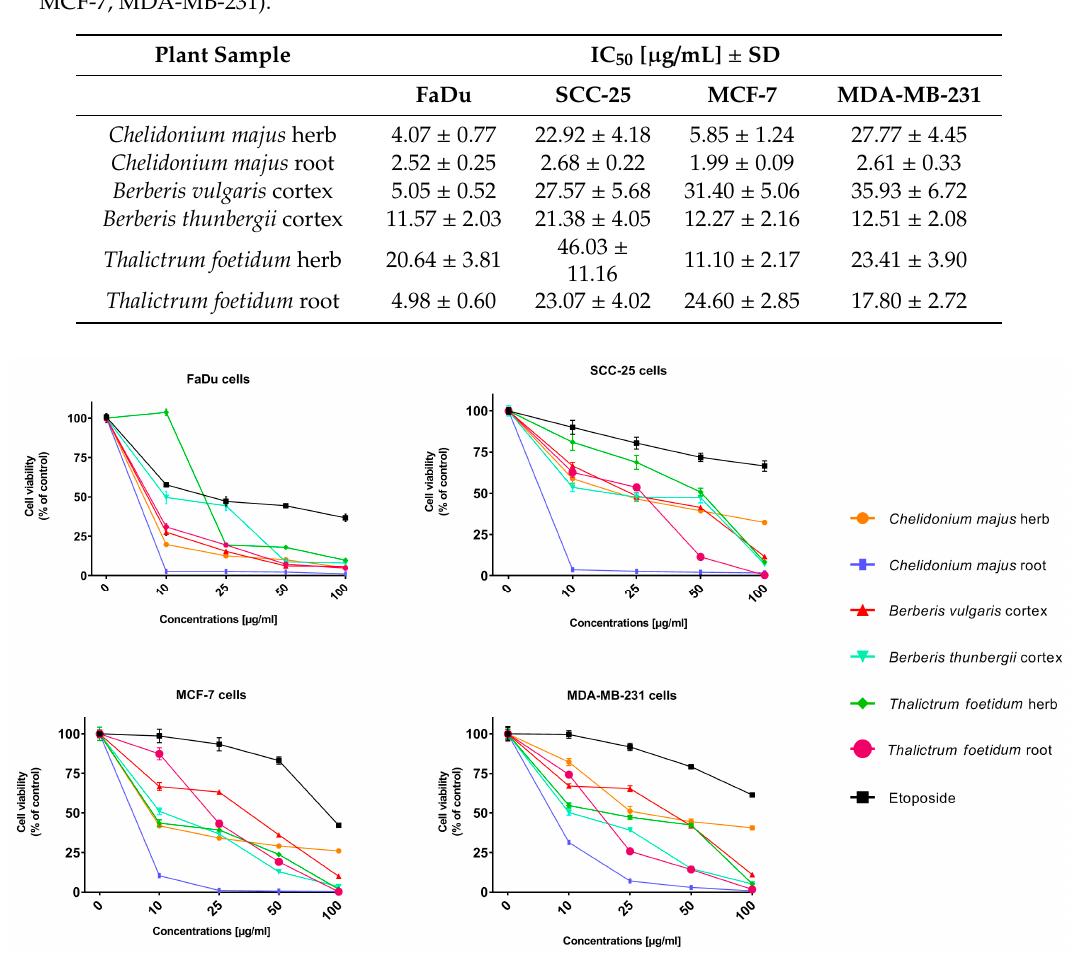
Table 4. Cytotoxic e ff ect of The investigated plant extracts against cancer cell lines (FaDu, SCC-25, MCF-7, MDA-MB-231).